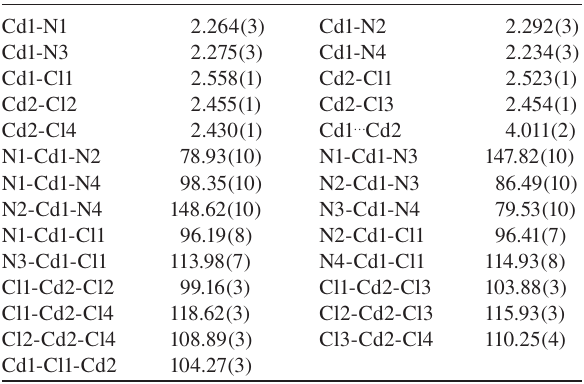
Table 1 Selected bond distances ( Å ) and angles ( ° ) for [Cd II (L)( µ - ] ( 1 Cl)Cd II Cl 3